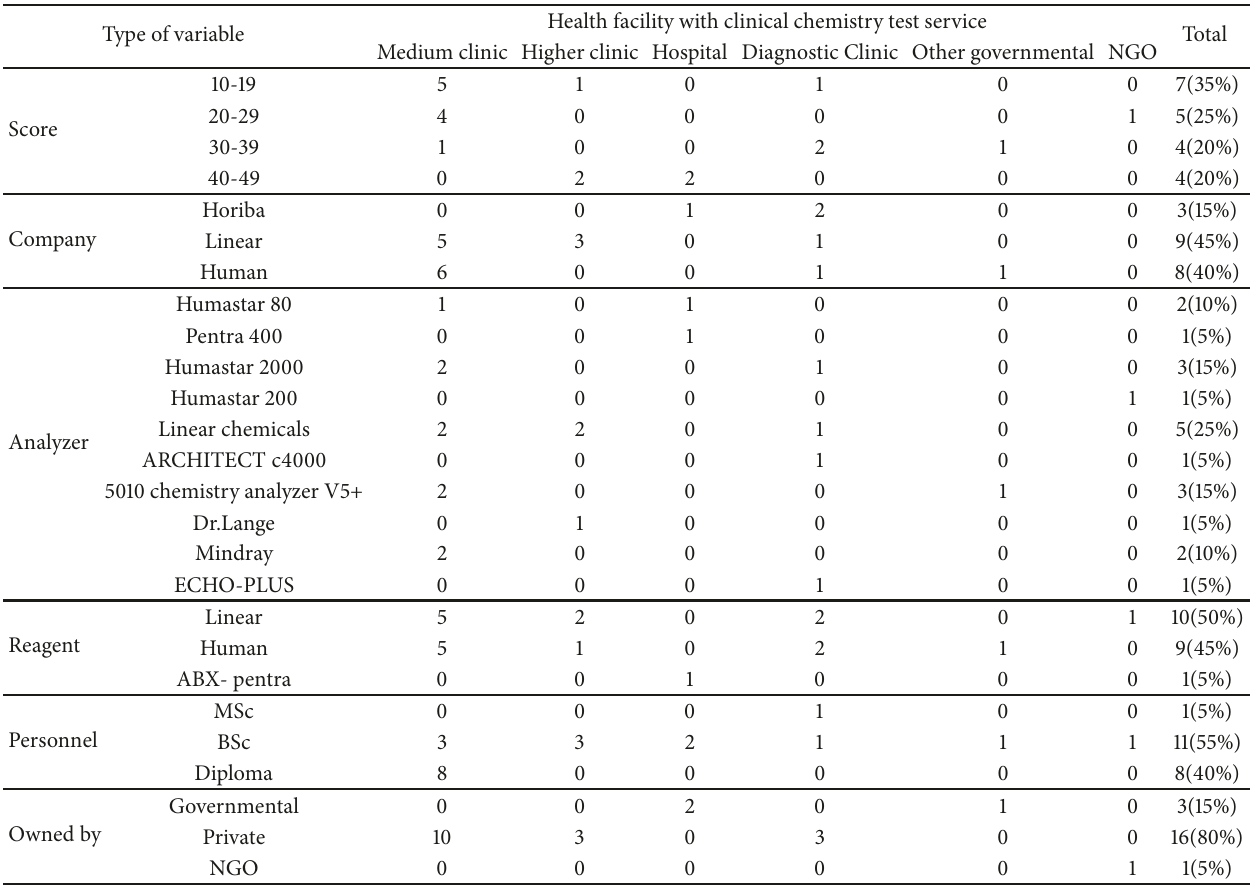
Table 2:Distribution of differentfactorsthatareexpectedtoaffectthequality ofclinicalchemistryserviceamong health facilitieswith clinical chemistry test service.